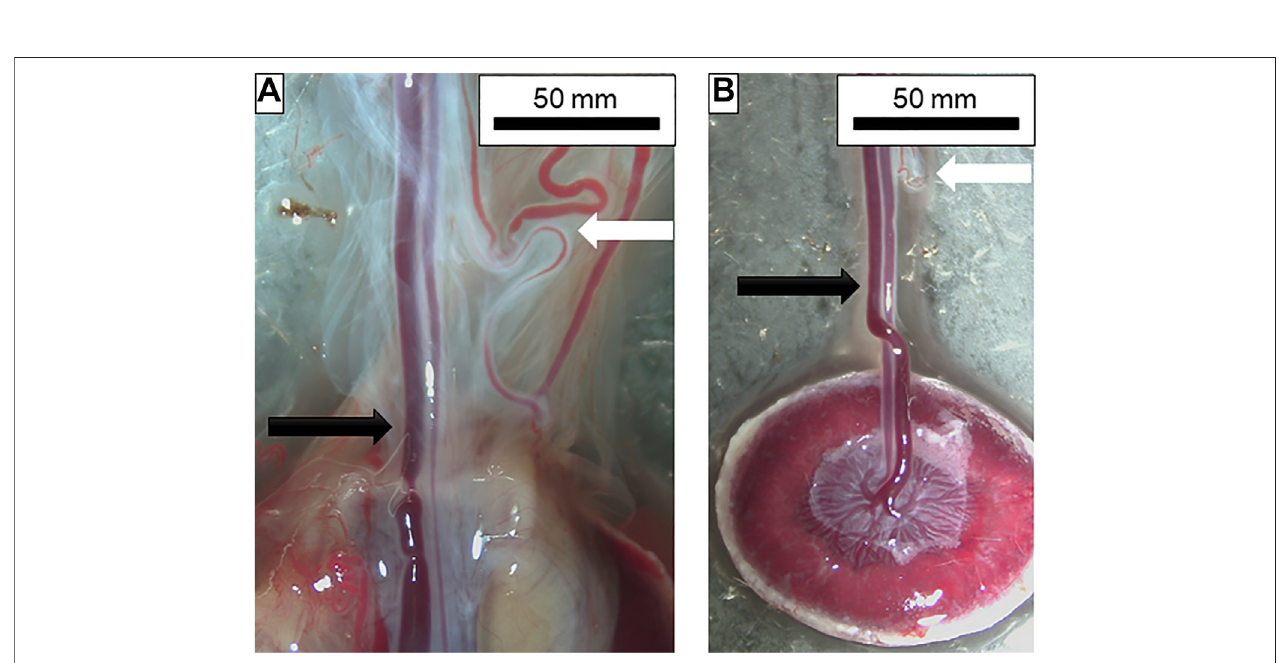
FIGURE2| Dissection ofplacental and chorionic vessels. (A) From left toright: umbilicalvein; umbilical artery;vitelline artery and otherchorionicvessels.Amnionic membranes can also be seen surrounding the vessels prior to removal. Black arrow indicates the umbilical artery and vein pair while the white arrow shows the vitelline arteryandchorionicvessels. (B) Placentalunitwithmembranesremovedandumbilicalarteryandveinisolated.Notethechorionicvesselswiththewhitearrowatthetop of the fi gure indicating how closely these two are prior to dissection. Vessel insertion and branching into the placenta can also be seen.